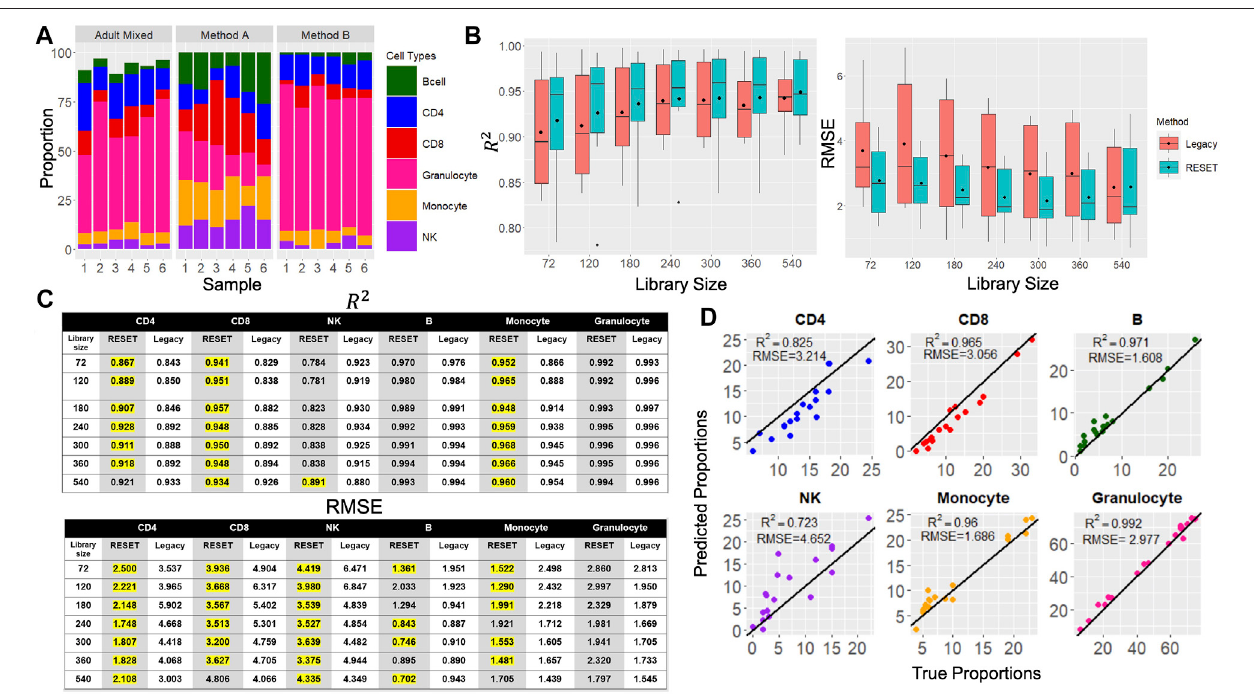
FIGURE 4 | Results from RESET and Legacy Approach. (A) True cell-type proportions for the three independent data sets used to generate predictions for the RESETandLegacyapproaches.Eachdatasetiscomprisedofsixsamplesandthesamesixleucocytesubtypes. (B) Boxplotsshowingthe R 2 andRMSEacrossallcell types for each assumed reference library size (recall J p (cid:1) { 72 , 120 , 180 , 240 , 300 , 360 , 540 } ) for RESET compared to the Legacy approach. (C) Table of results comparing the prediction performance of the RESET algorithm and the Legacy approach for each cell type and across different assumed reference library sizes (rows of the table). The top table shows the R 2 while the bottom table shows the RMSE, calculated by comparing the predicted/estimated versus observed cell proportions. Yellow highlighted text denotes the conditions where the use of RESET resulted in better prediction performance than the Legacy approach. (D)